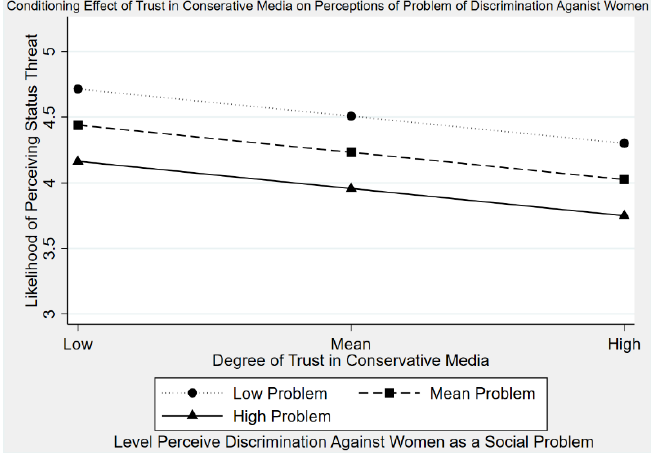
Figure 1. Conditioning Effect of Conservative Media: Discrimination against Women and Status Threat.